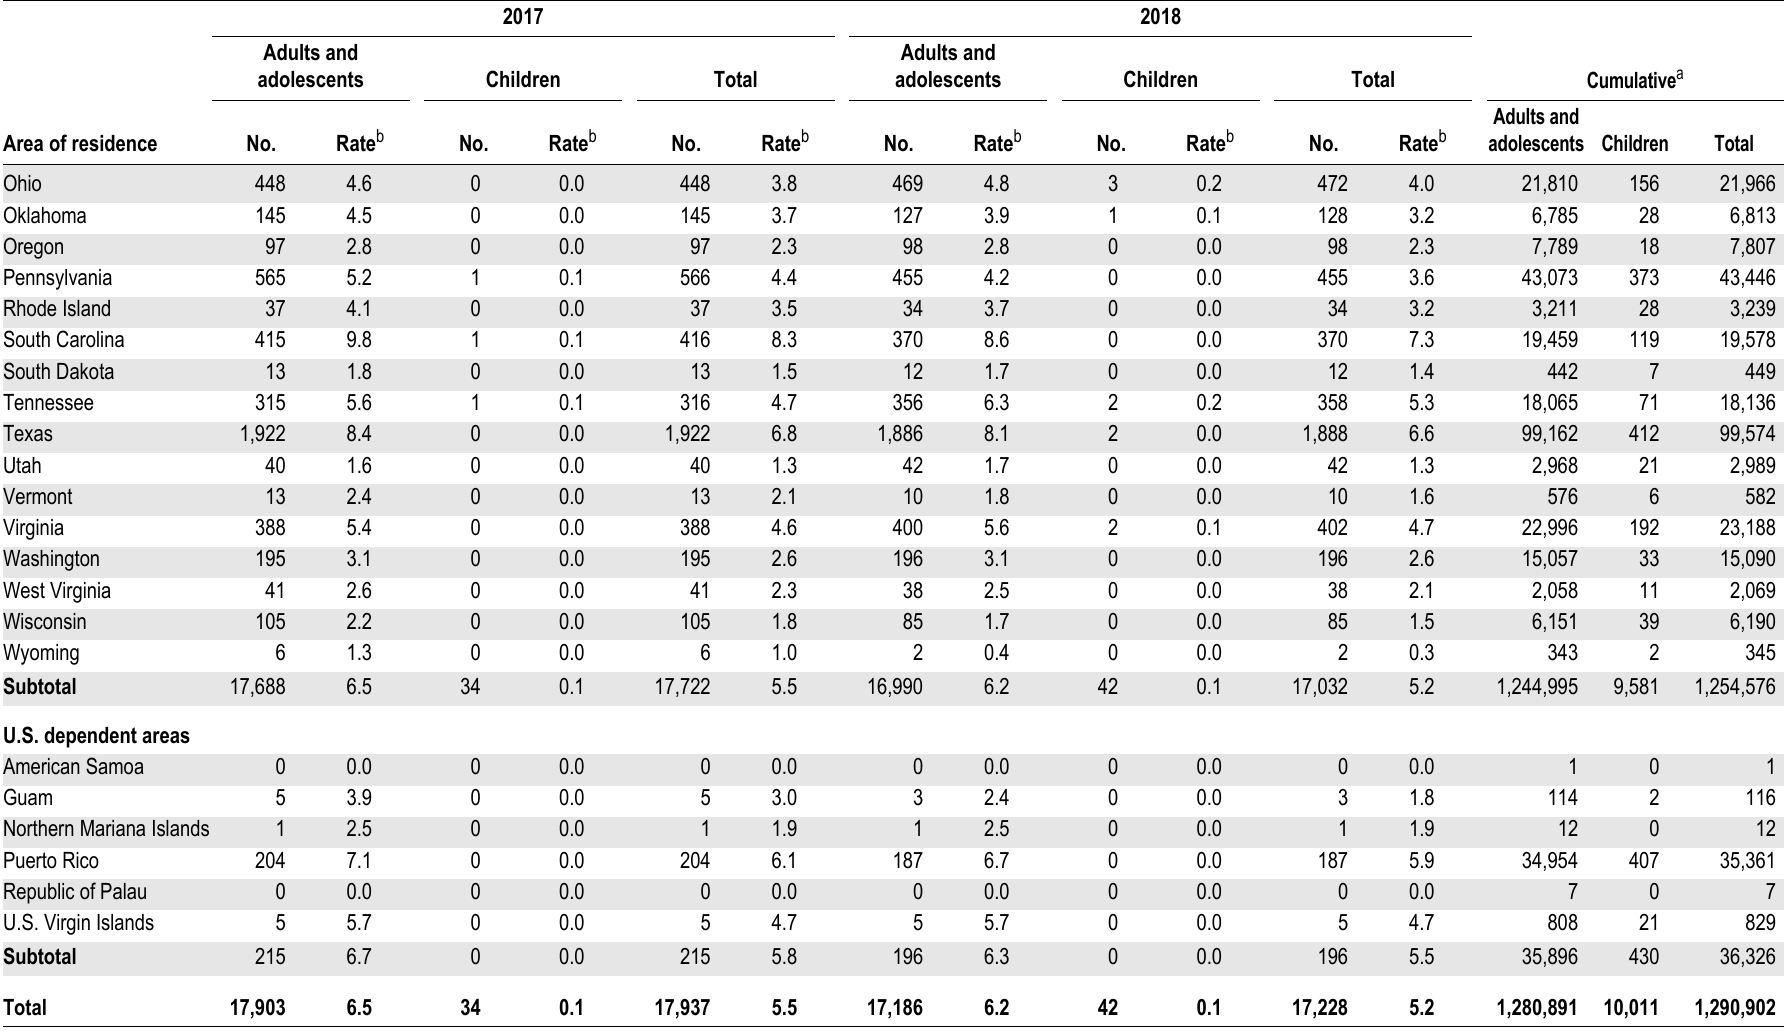
Table 27. Stage 3 (AIDS), by area of residence, 2017, 2018, and cumulative—United States and 6 dependent areas